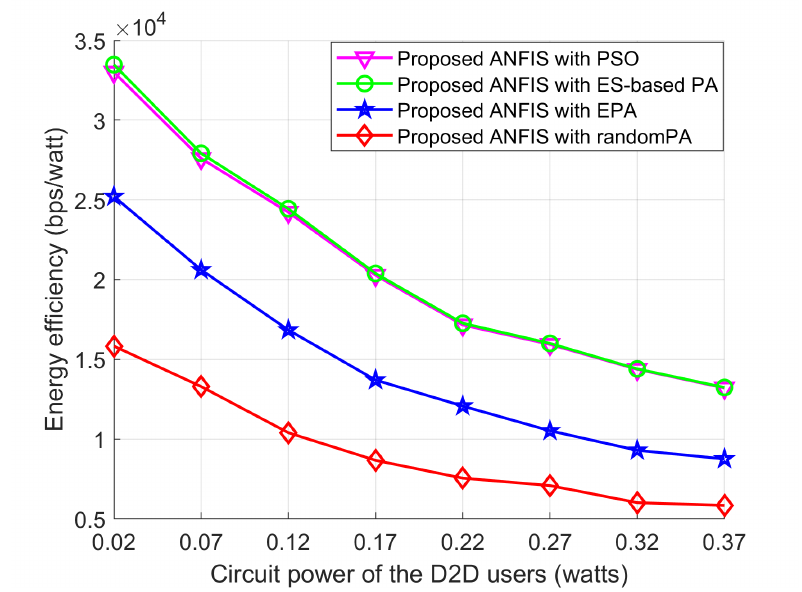
Figure 16. EE performance with P Cir